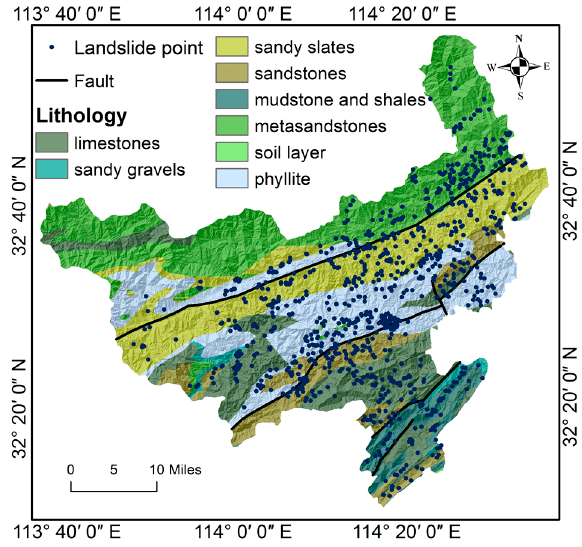
Figure 1. Lithological map of Qingchuan area and locations of landslide points.